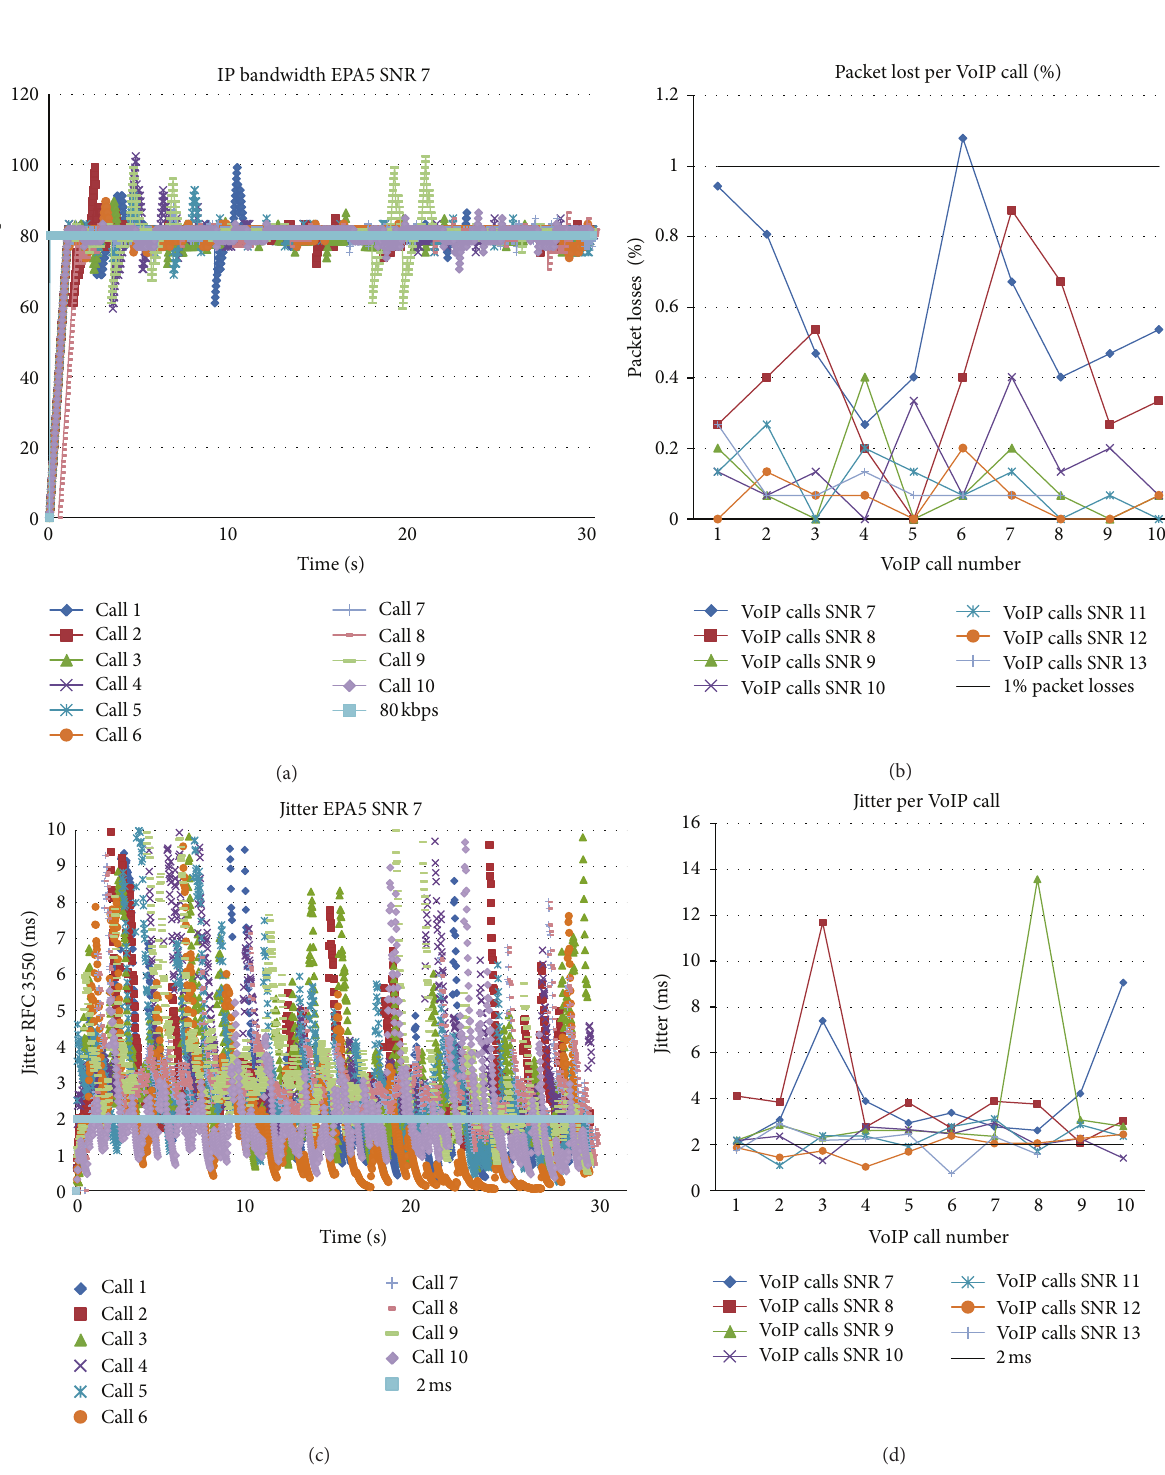
Figure 3: IP performance parameters analysis. (a) Instant IP bandwidth measurements during 10 VoIP calls in an EPA5 LTE scenario with a 7dB of SNR. (b) Packet losses per VoIP call for different levels of SNR in an EPA5 scenario. (c) Instant jitter measurements during 10 VoIP calls in a EPA5 LTE scenario with a 7dB of SNR. (d) Mean Jitter per VoIP call for different levels of